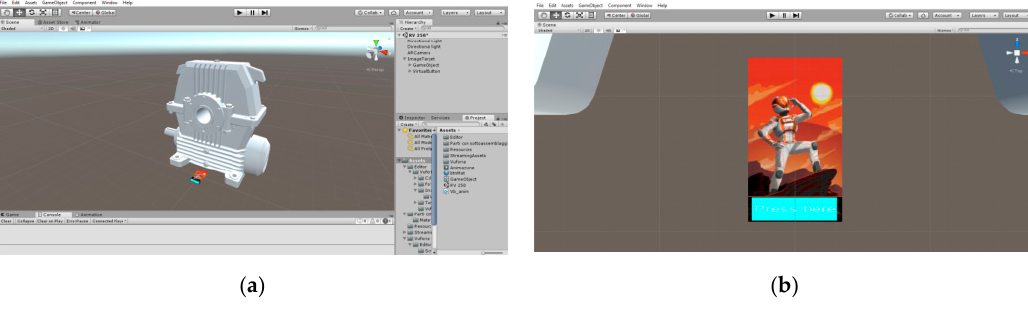
Figure 33. ( a , b ) View of VirtualButton with Unity (scale 1:1).